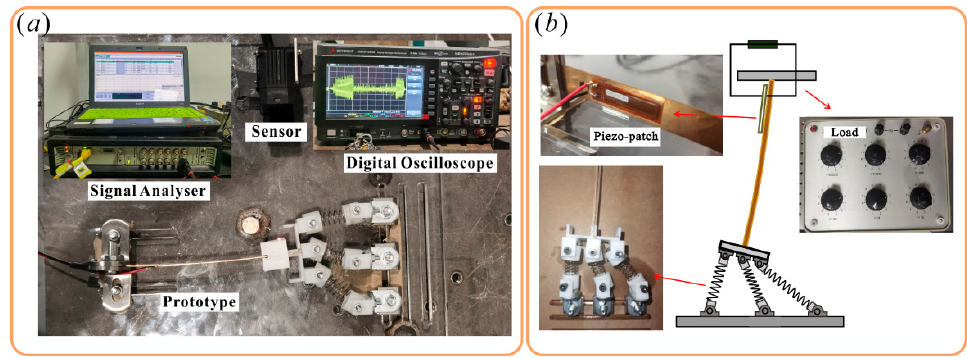
Figure 10. ( a ) Experimental setup; and ( b ) Prototype.